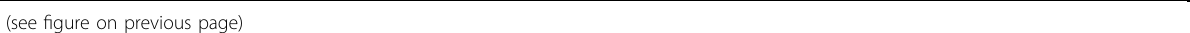
Fig. 2 Effect of NDUFA4L2 on GBM cell growth and NDUFA4L2 knockdown induces mitophagy in GBM cells. A mRNA and protein levels of NDUFA4L2 in T98G cells transfected with three different small interfering RNAs (siRNAs) against NDUFA4L2 or si-NC were quanti fi ed by qRT-PCR and western blotting. B qRT-PCR and western blotting results of U138 and GBM-XX cells transfected with pcDNA-NC or pcDNA-NDUFA4L2 are shown. C Cell viabilities of si-NDUFA4L2-transfected T98G and pcDNA-NDUFA4L2-transfected LN229 cells were determined by CCK8 assay. D Colony-forming abilities of si-NDUFA4L2-transfected T98G and pcDNA-NDUFA4L2-transfected GBM-XX cells were determined by colony formation assays. E Cell viabilities of si-NDUFA4L2-transfected T98G and pcDNA-NDUFA4L2-transfected GBM-XX cells were determined by 5-ethynyl-2 ′ -deoxyuridine retention assay. F Flow cytometry was performed to analyze cell cycle progression in si-NDUFA4L2-transfected T98G and pcDNA-NDUFA4L2- transfected GBM-XX cells. G Protein levels of LC3, p62, Beclin-1, and ATG7 in LN229 and GBM-XX cells transfected with si-NDUFA4L2 or si-NC were determined by western blotting. H Representative transmission electron microscopy images of si-NDUFA4L2-transfected LN229 and GBM-XX cells. I , J si-NDUFA4L2 or si-NC transfected LN229 and GBM-XX cells stably expressing the stubRFP-sensGFP-LC3 fusion protein were established and observed by fl uorescence microscopy. K Immuno fl uorescence images showing DAPI (blue), cytochrome C (green), and NDUFA4L2 (red) staining, as well as merged images of the three signals. L Protein levels of PINK1 and Parkin in LN229 and GBM-XX cells transfected with si-NDUFA4L2 or si-NC were determined by western blotting. The images shown are representative of three experiments. Means ± SDs of triplicate experiments are plotted. * p < 0.05, ** p < 0.01, *** p < 0.001, n.s. not statistically signi fi